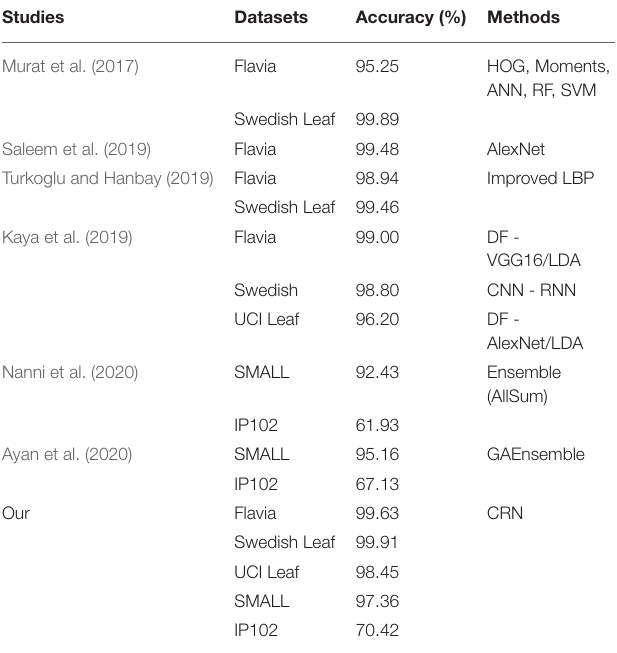
TABLE 4 | Accuracy of CRN on plant image datasets (Flavia, Swedish Leaf, and UCI Leaf) and pest image datasets (SMALL and IP102).